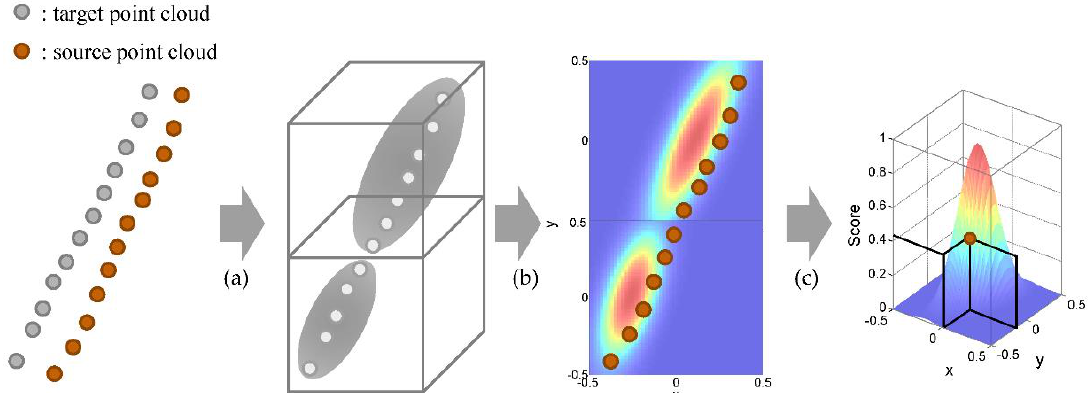
Figure 6. Process of basic Normal Distribution Transform [102] ( a ) Construction of the normal distribution with target point clouds. ( b ) Projection of the source point clouds into the normal distribution. ( c ) Score calculation for each source point.